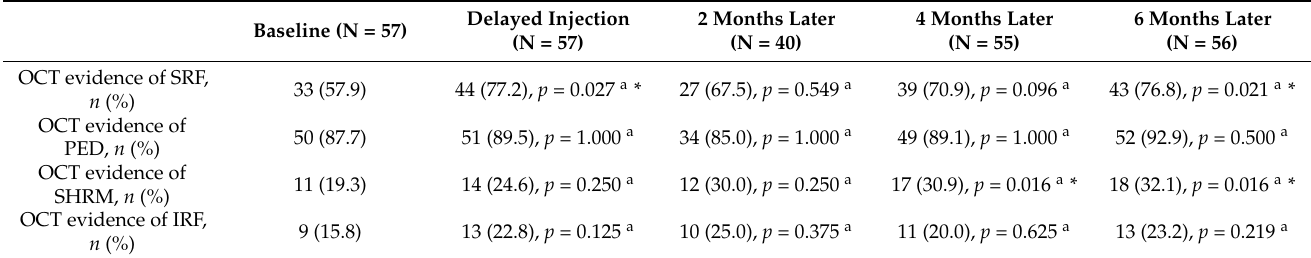
Table 2. Differences in OCT findings at different visits.